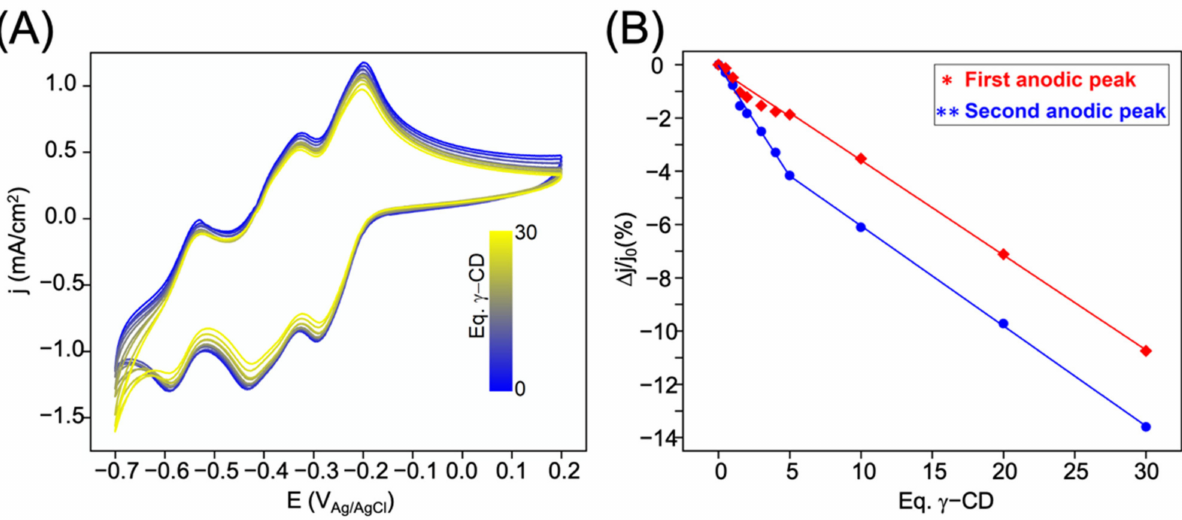
Figure 4. ( A ) Cyclic voltammograms of the [NaP 5 W 30 O 110 ] 14 − anion (1 mmol · L − 1 , glassy carbon working electrode, scan rate 200 mV · s − 1 ) in the presence of increasing amounts of γ -CD (from 0 to 30 equivalents). The experiments have been performed in 50:50 ( v:v ) HCl (0.1 mol · L − 1 ):NaCl (0.9 mol · L − 1 ) aqueous solution (pH = 1.3). ( B ) Plot of the variation of the first (red filled diamond-shaped symbol) and the second (blue filled circle symbol) cathodic peaks extrema versus equivalent number of γ -CD showing a break point at ca. 5 eq. CD (j 0 = cathodic peak current density of [NaP 5 W 30 O 110 ] 14 − anion without γ